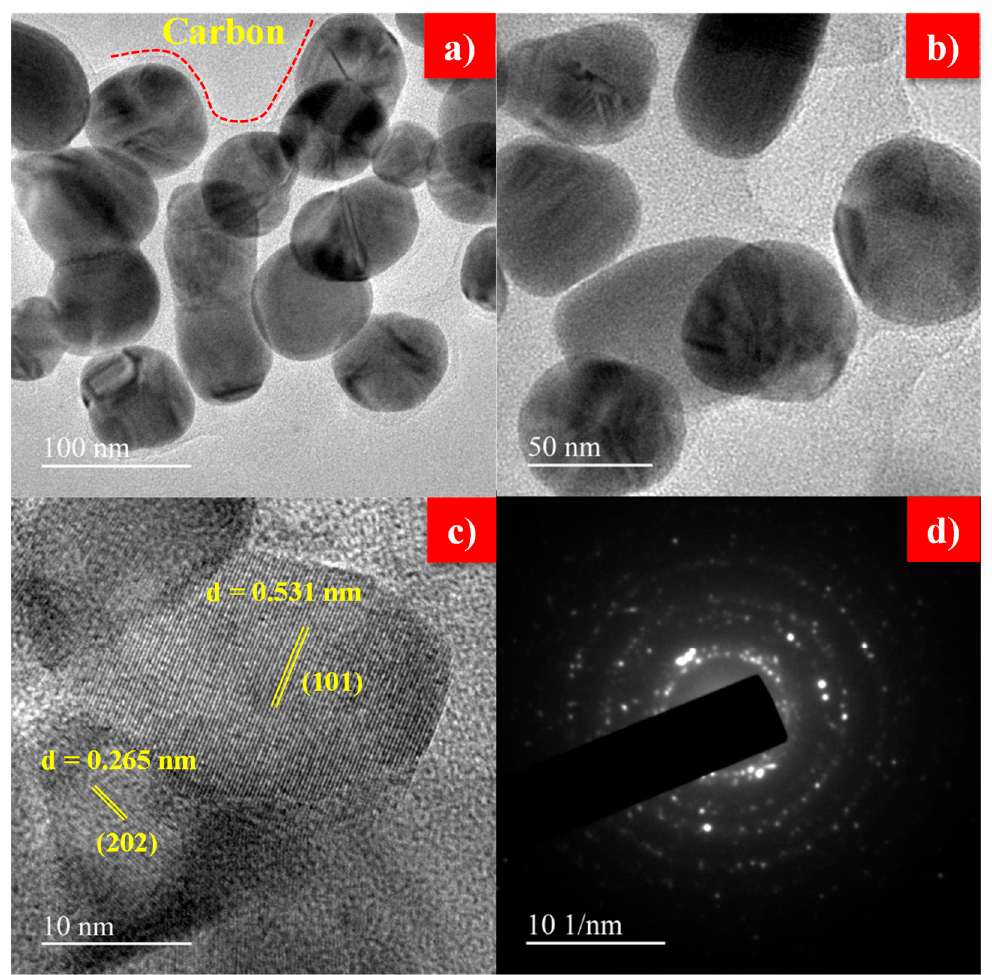
Figure 3. ( a , b ) TEM images, ( c ) lattice fringes and ( d ) SAED of as-synthesized Li 2 FeSiO 4 /C.